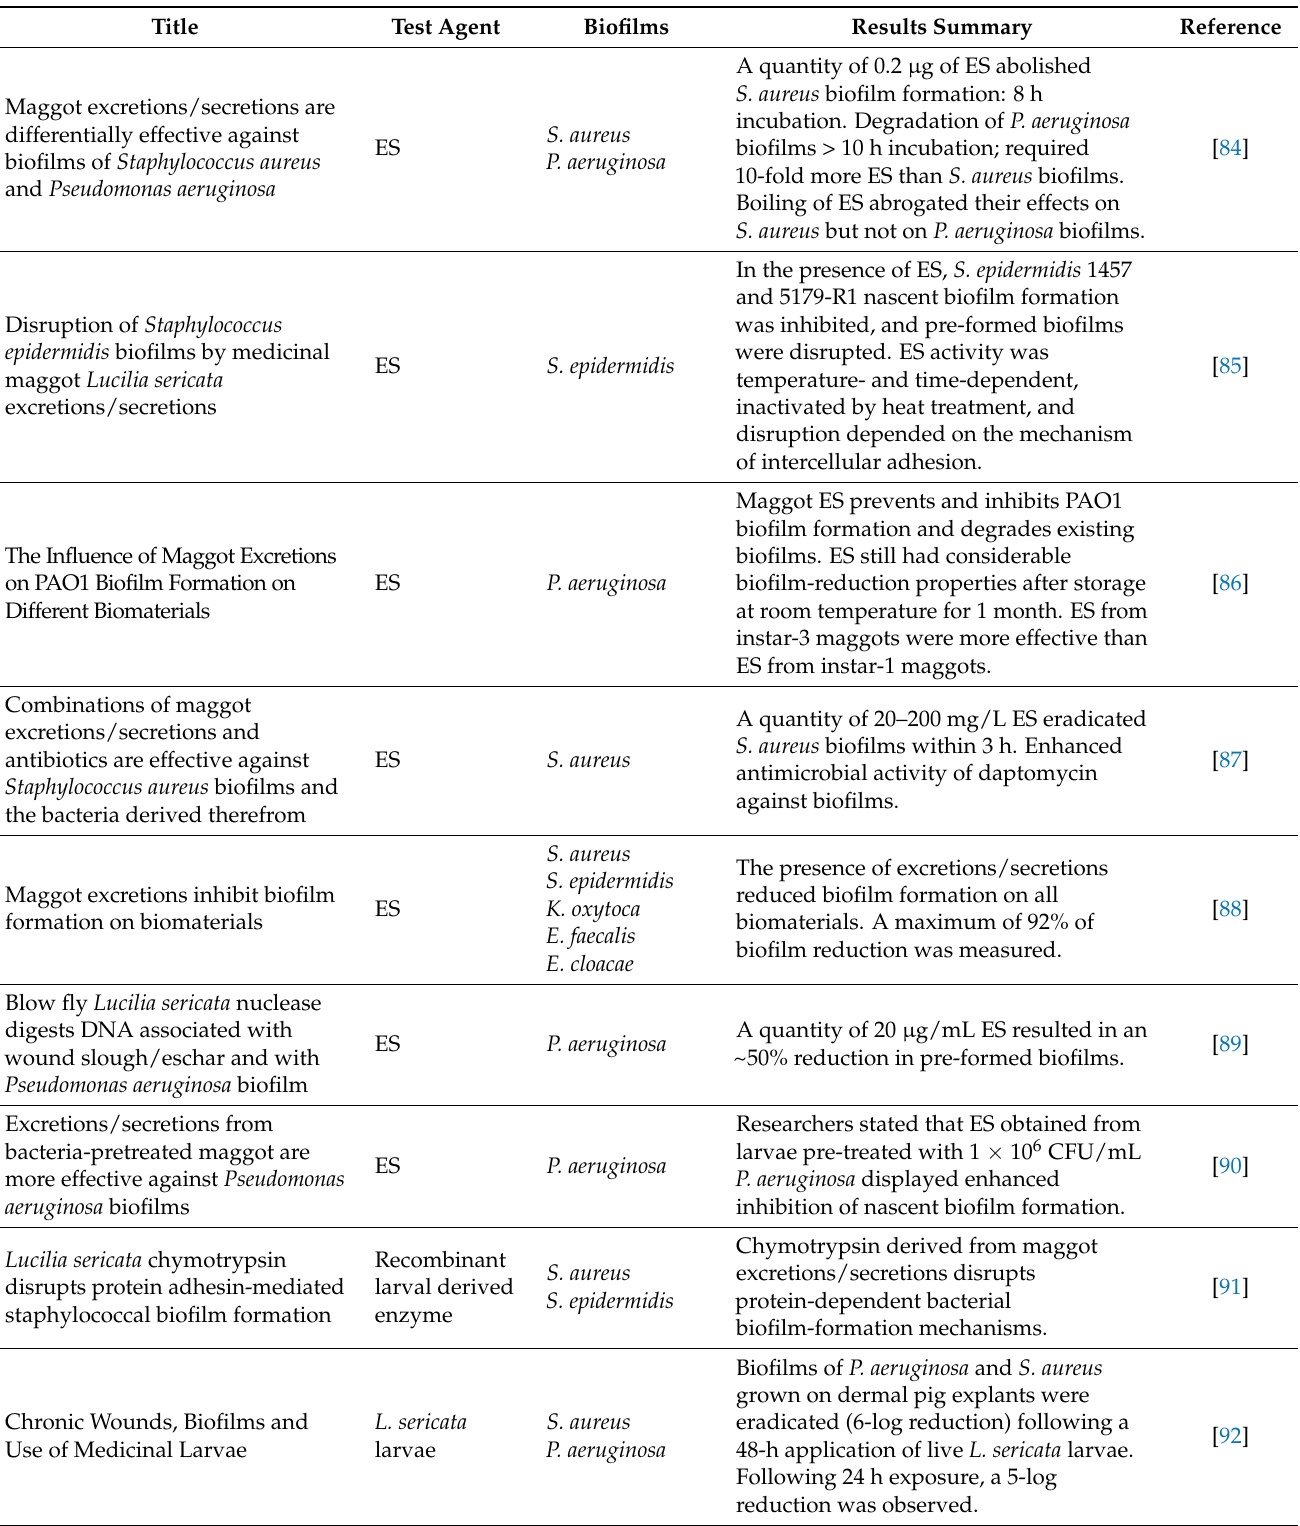
Table 1. Summary of papers analyzed following the PRISMA-informed literature